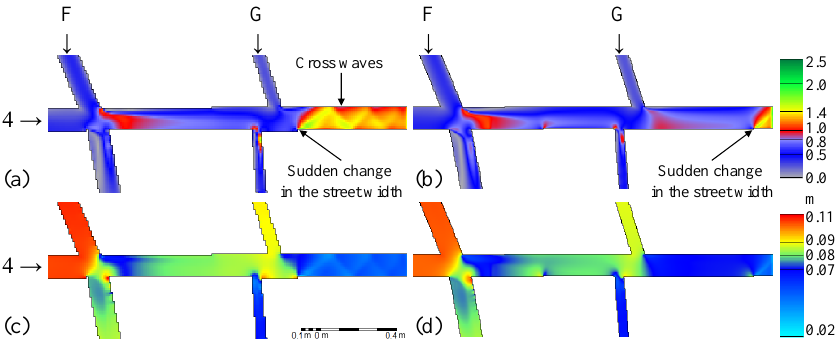
Figure 9. Froude numbers (a, b) and water depths (c, d) computed for test Q100-W050 and cell sizes of 1cm (a, c) and 5mm (b, d) .